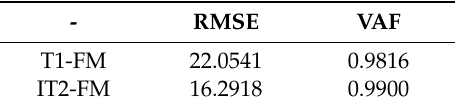
Table 3. Comparison of the fuzzy models. VAF, variance accounted for.